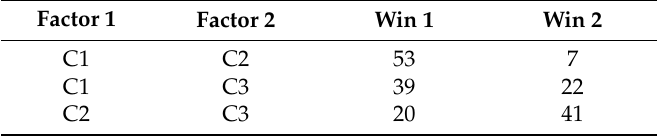
Table 8. Input file of Customer (C) factors preferences in a win-to-loss